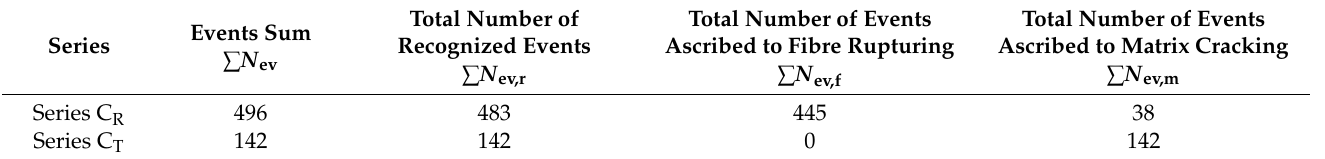
Table 5. Events recognized as accompanying the rupturing of fibres and cracking of the cement matrix for boards of series C R and C T